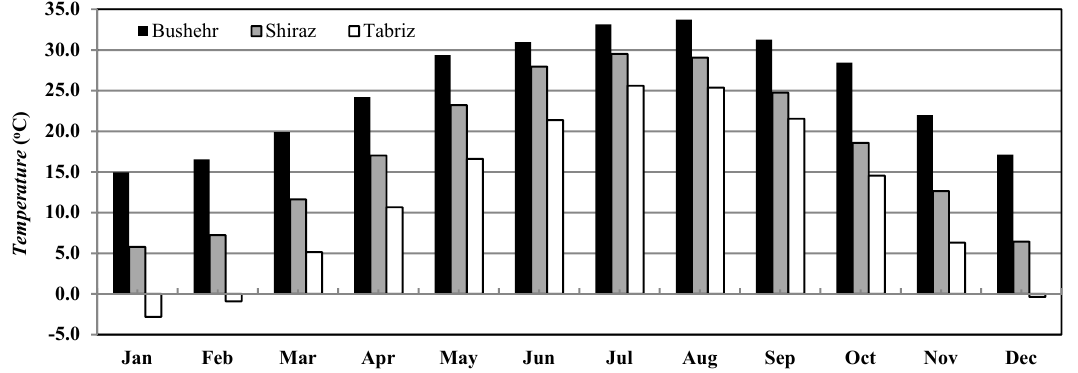
Figure 2. Average monthly temperatures of Shiraz, Tabriz, and Bushehr for the period of 2006–2016 (Data from the Iran Meteorological Organization).